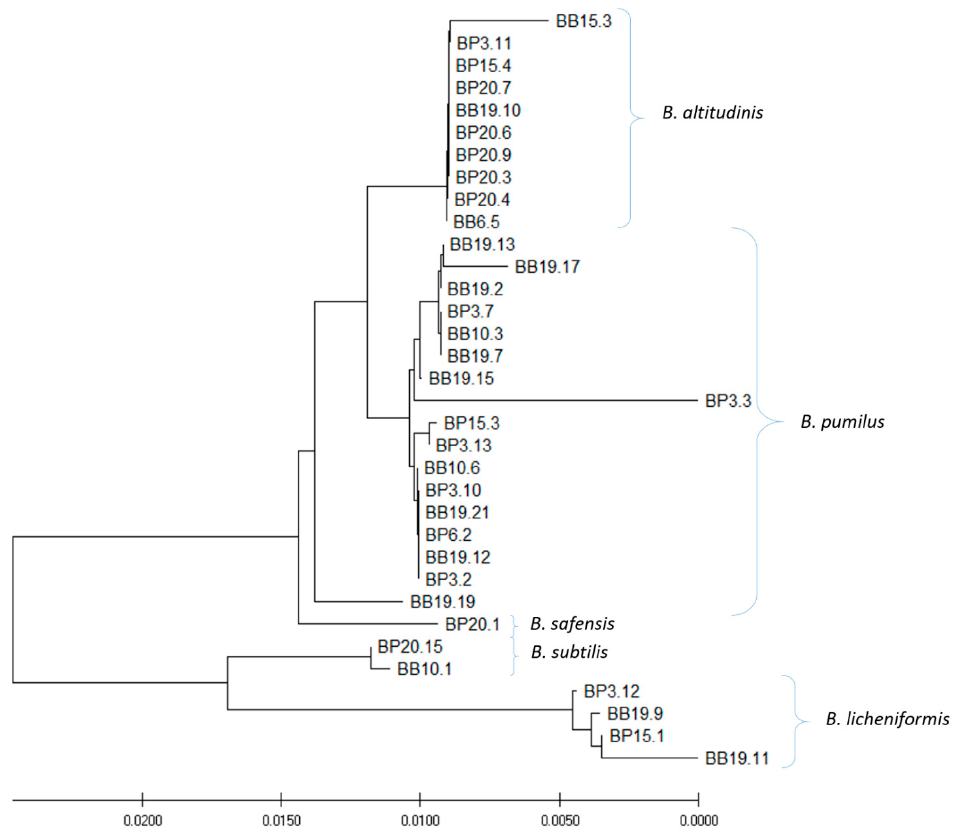
Figure 2. Phylogenetic tree of 34 strains that exhibited antagonistic potential against at least of one reference strain of pathogenic bacteria. MUSCLE multiple alignment/construction was done using the neighbor − joining method. Five clusters of the strains could be distinguished, which was in agreement with spe- cies identification.